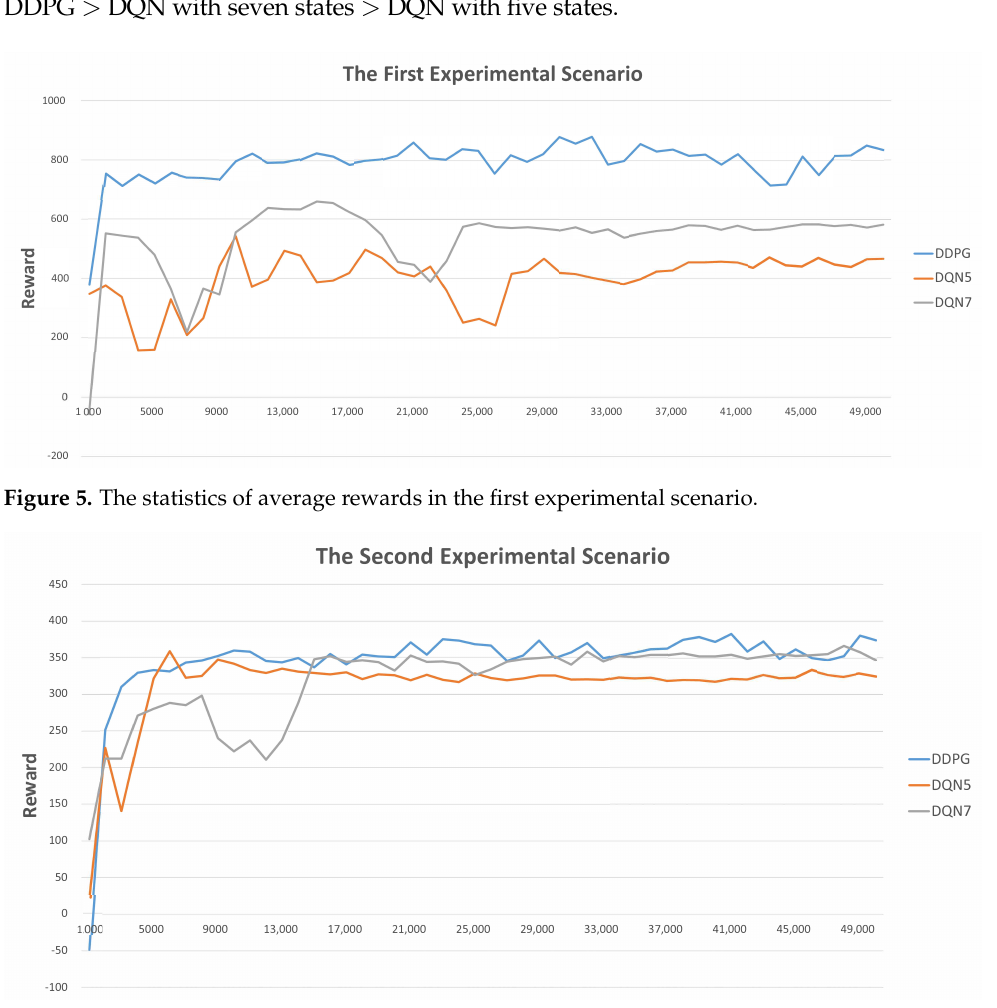
Figure 6. The statistics of average rewards in the second experimental